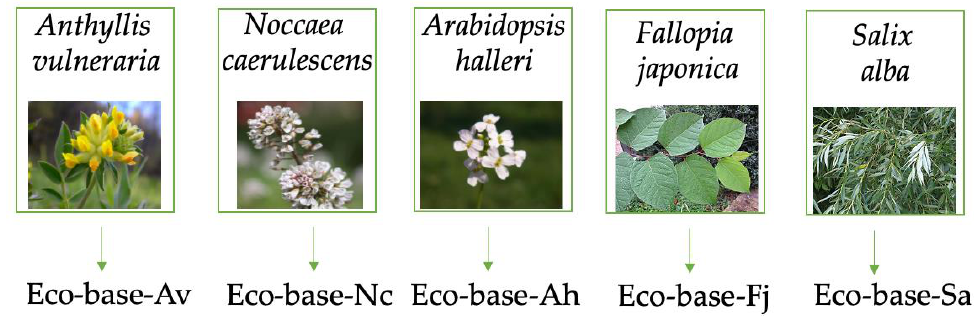
Figure 1. Plant species selected for the preparation of Eco-bases.